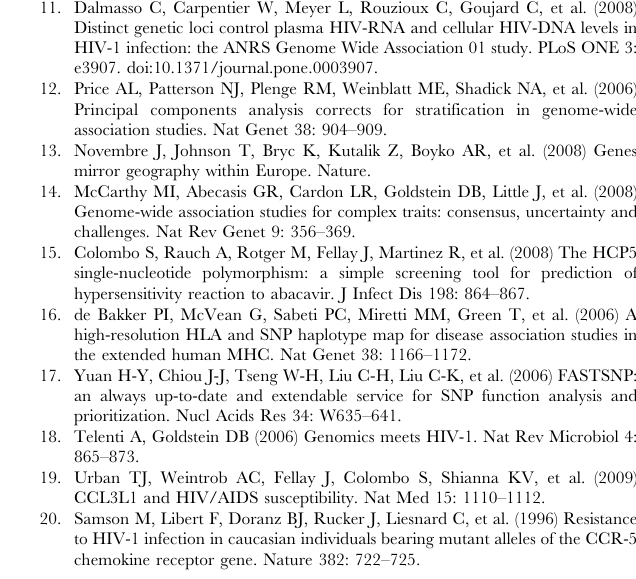
Table S8 Comparison of the strength of the association results for polymorphisms with clear association with HIV outcomes using different definitions of progression in survival analyses.